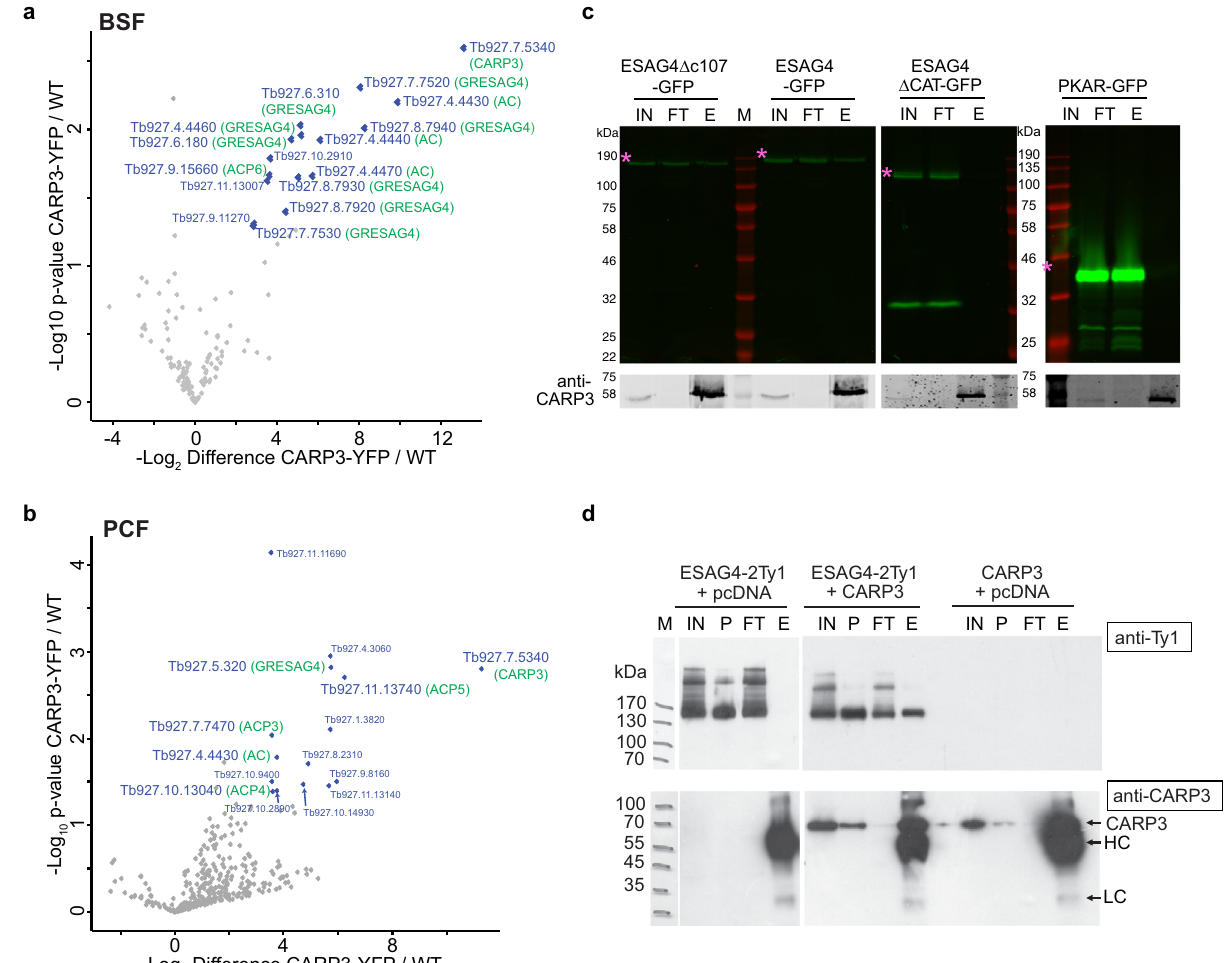
Fig. 5 | CARP3 interacts with ACs. Volcano plot representation of proteins iden- ti fi eduponGFPtrappull-downin T.brucei AnTat1.1ECARP3-YFPcellscomparedto wild type (WT) in BSFs ( a ) or PCFs ( b ) ( n =2 replicate pull-downs each). Identi fi ed proteins are plotted according to p value and fold change with signi fi cantly enri- ched proteins ( p value ≤ 0.05, fold change ≥ 10) shown in blue with their TriTrypDB entries (https://tritrypdb.org). The bait protein CARP3 and AC isoforms are indi- cated in green. c CARP3 immunoprecipitation (anti-CARP3 coupled to protein A beads) in BSF cell lines expressing ESAG4-GFP, ESAG4 Δ c107-GFP, or ESAG4 Δ CAT- GFP, respectively. Pull-down assays in a PKAR-GFP cell line served as negative control. Upper panels: detection of GFP by in-gel fl uorescence; lower panels: